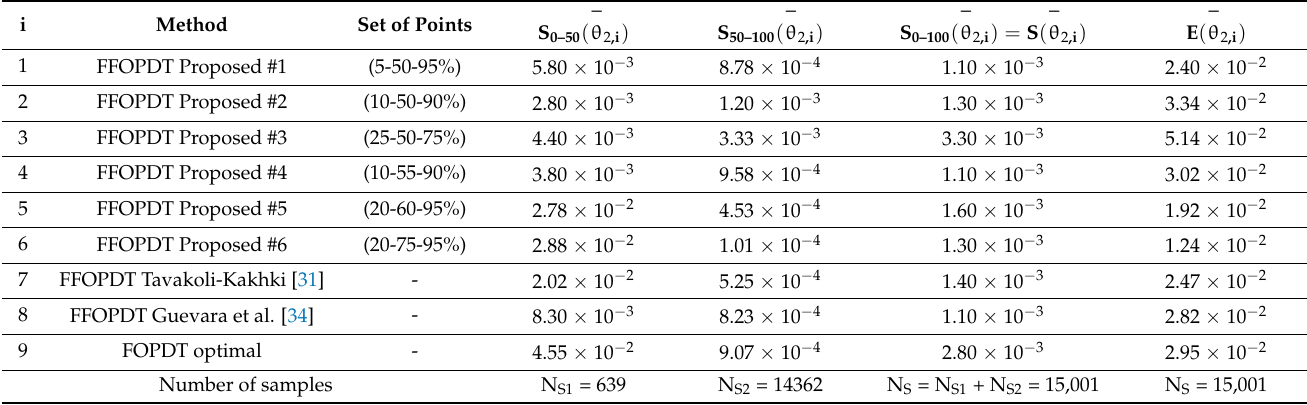
Table 19. Comparison between the performance indexes obtained for the proposed method with different sets of points, symmetrical and asymmetrical, and the ones for several methods for FFOPDT and FOPDT models. The number of samples N S for the whole range and for each interval are also